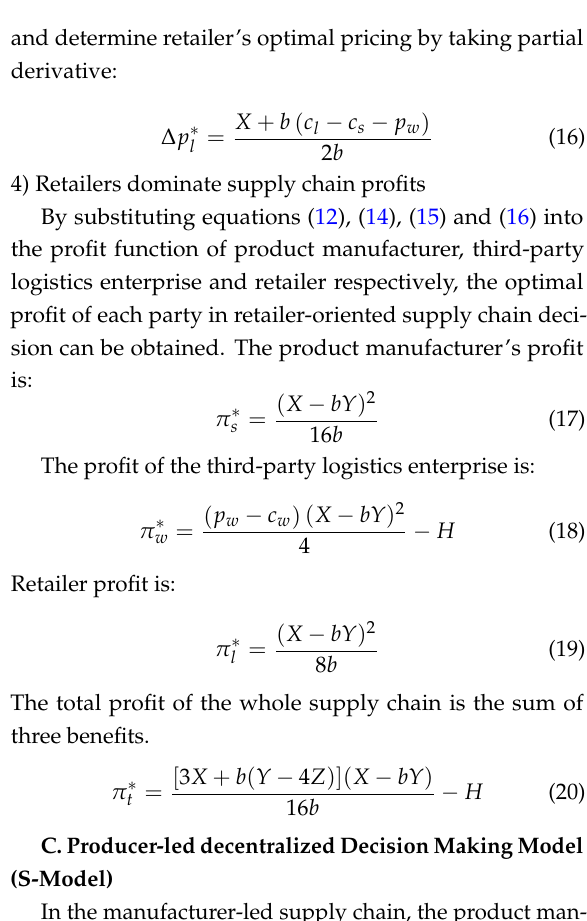
Third party logistics is not